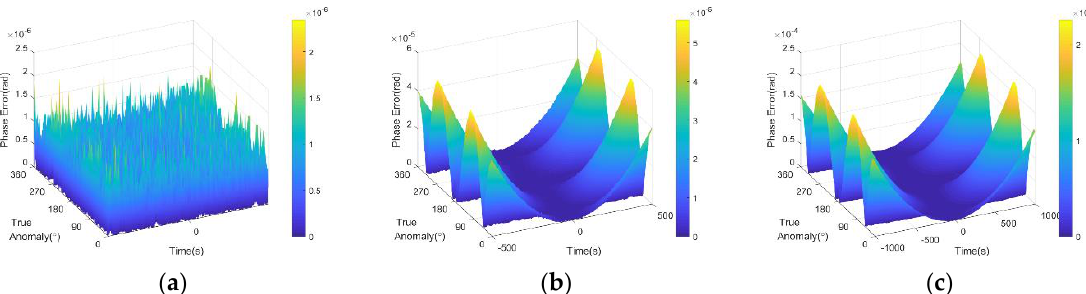
different integration times. ( a ) 100 s; ( b ) 1000 s; ( c ) 2000 s. ferent integration times. ( a ) 100 s; ( b ) 1000 s; ( c ) 2000 s.